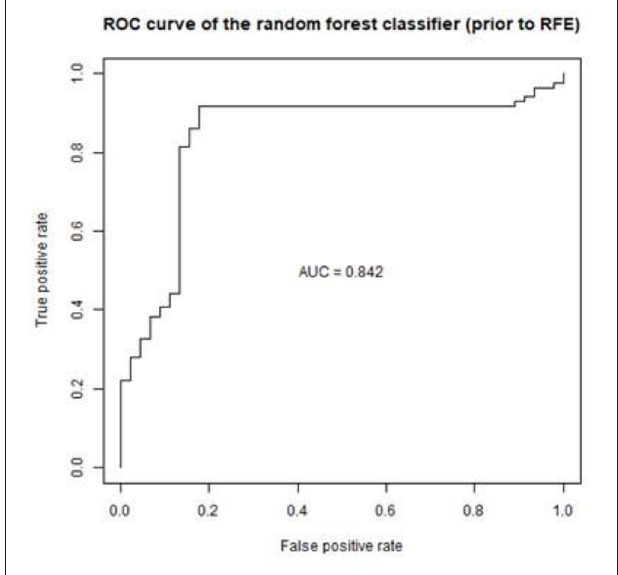
FIGURE 4 | Graph depicting the ROC curve of the prediction model (sensitivity 75.56% and specificity